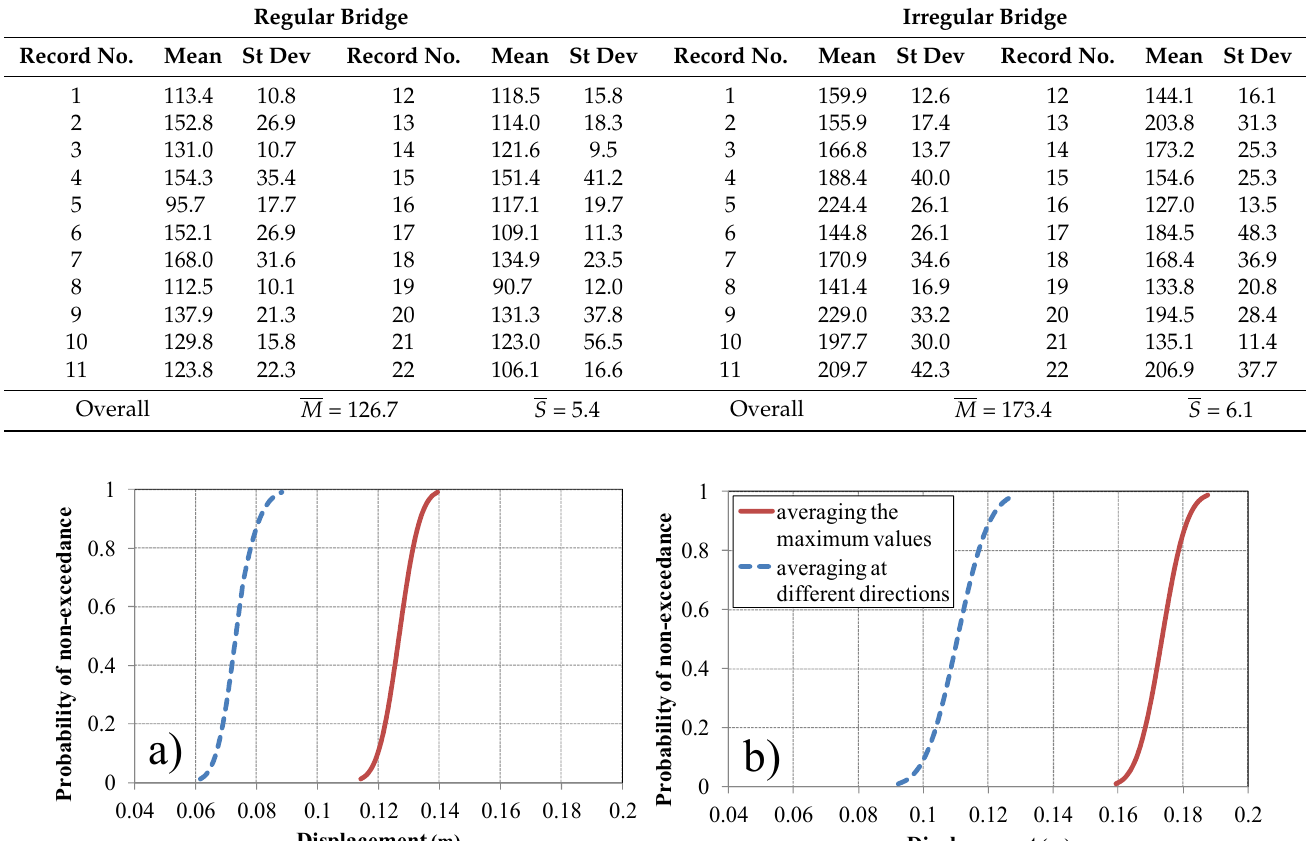
Table 5. Mean and standard deviation of the central column displacements (mm) for different records applied at different angles, θ . Regular Bridge Irregular Bridge Record No. Mean St Dev Record No. Mean St Dev Record No.